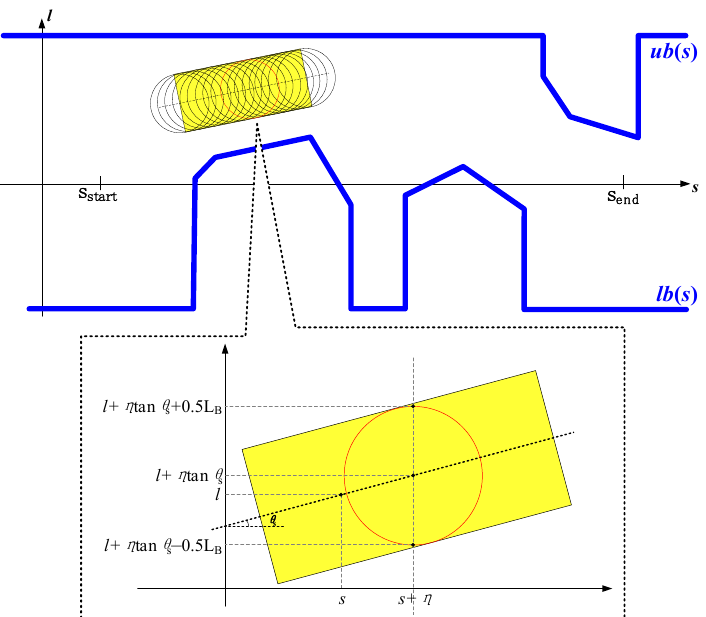
Figure 7. Schematics for the formulation of collision-avoidance constraints in EM planner (zoom in to see more clearly).